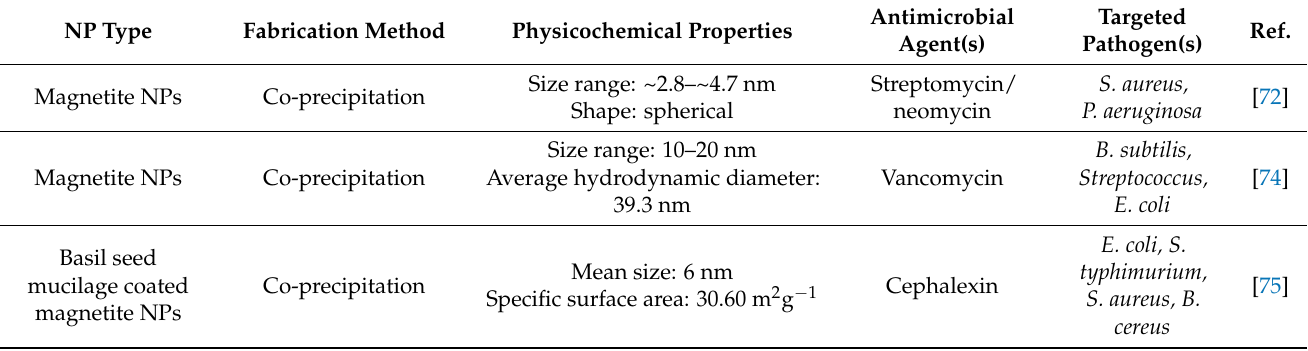
Table 2. Examples of antibacterial